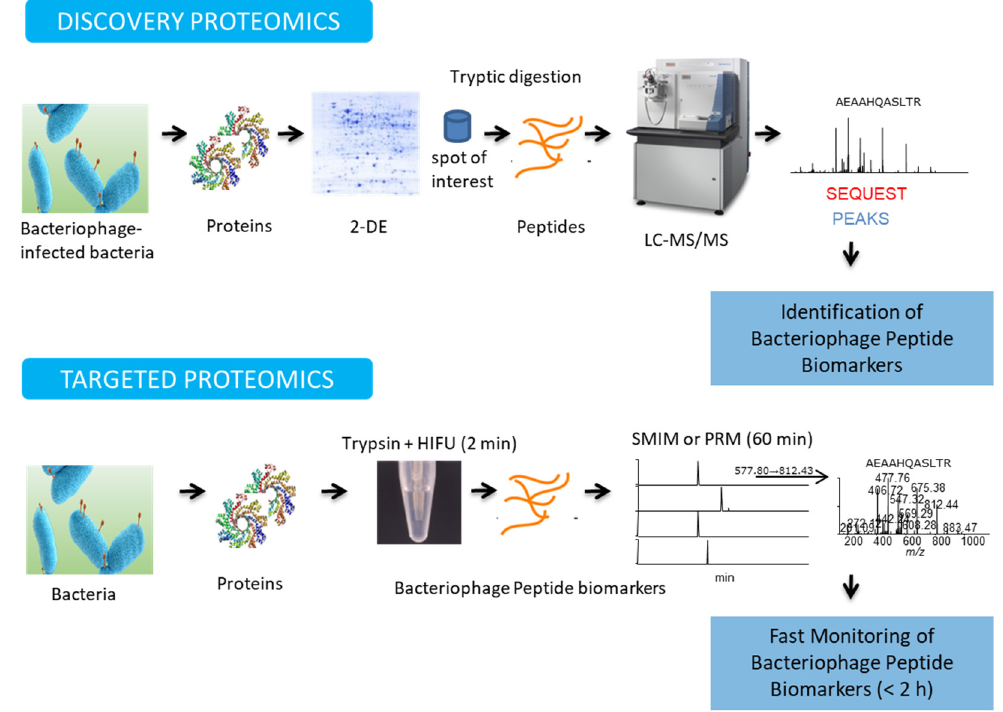
Figure 5. Sequential workflow required to engineer bacteriophage-based mass spectrometry proteomics (Discovery proteomics and Targeted proteomics). Discovery proteomics: protein extracts, from bacteriophage infected bacteria, are purified and separated by two-dimensional gel electrophoresis (2-DE) and stained. The proteins of interest, that appear as spots, are then excised from the gel, and digested with trypsin overnight; with the resulting peptides analyzed by liquid chromatography, coupled to tandem mass spectrometry (LC-MS/MS). The MS spectra obtained permits peptide identification, using search engines such as Se-quest; in the case that the MS spectra is not sufficient for peptide identification, the unknown peptides must be subjected to de novo sequencing, using platforms such as Peaks. The molecules identified as specific for a particular bacteriophage, are then selected as peptide biomarkers; these are the peptides to be monitored in targeted